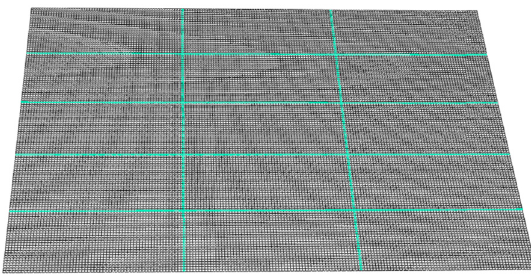
Figure 12: FEM simulation model of grillage structure.